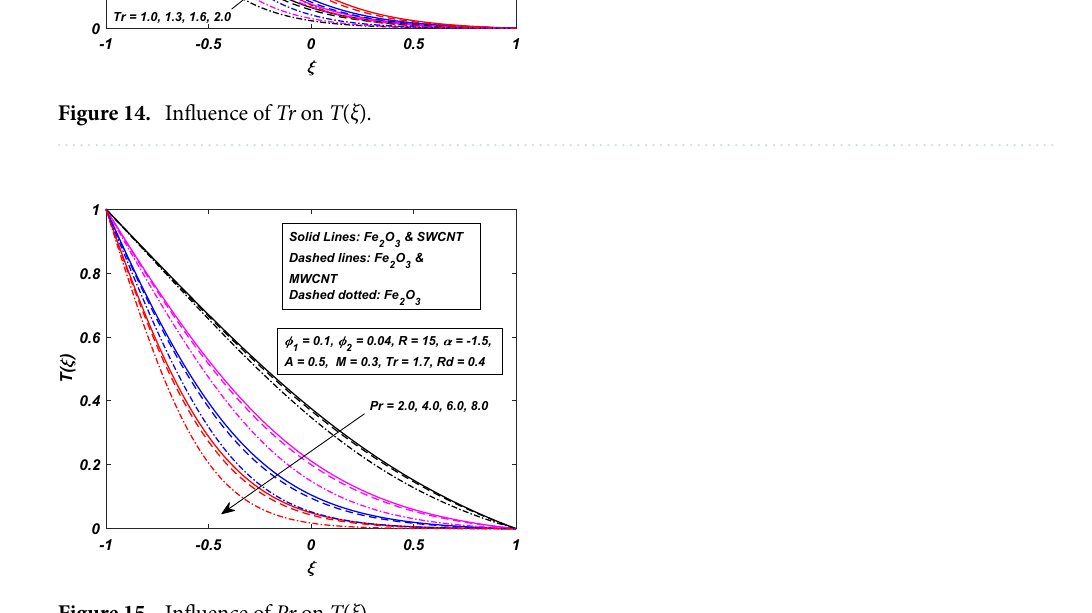
Figure 15. Influence of Pr on T ( ξ